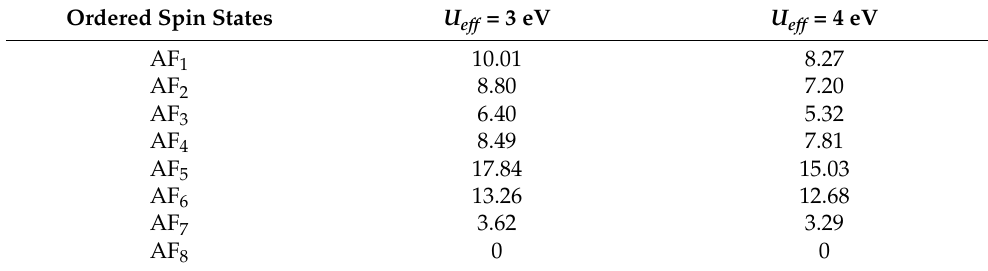
Table 1. Relative energies (in meV/FU) of the eight ordered spin states obtained from DFT + U calculations.